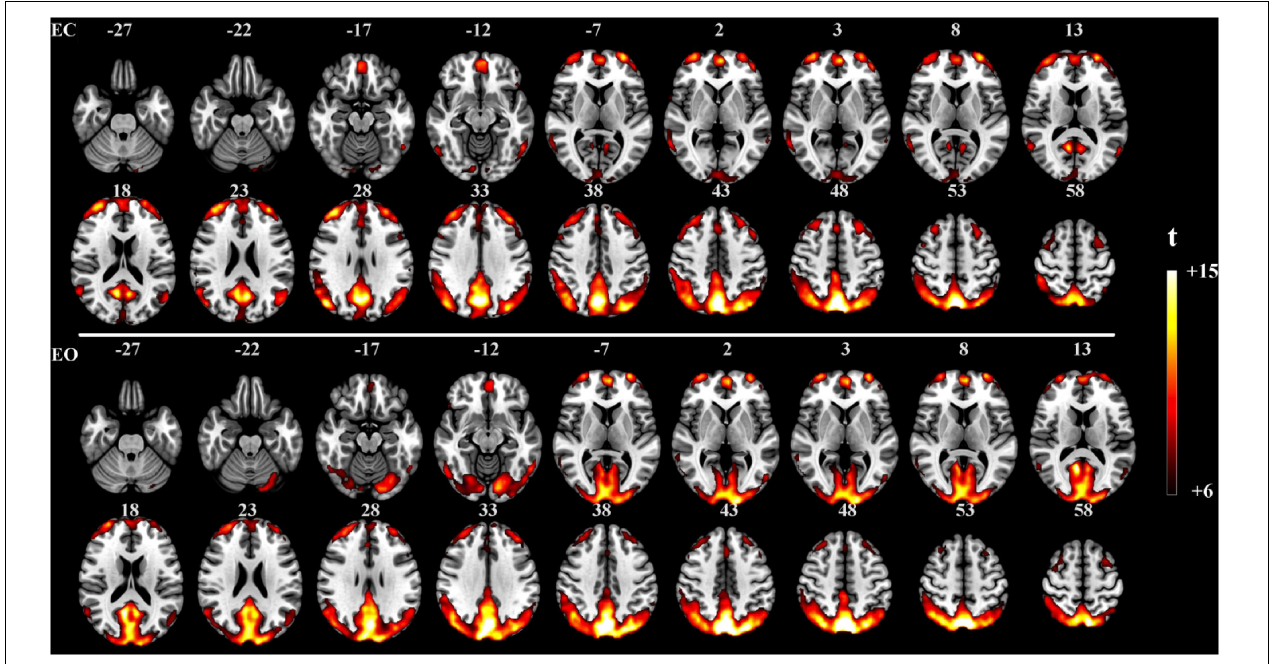
FIGURE 2 | Extracted SCM maps for six subjects in the visual task-related dataset.